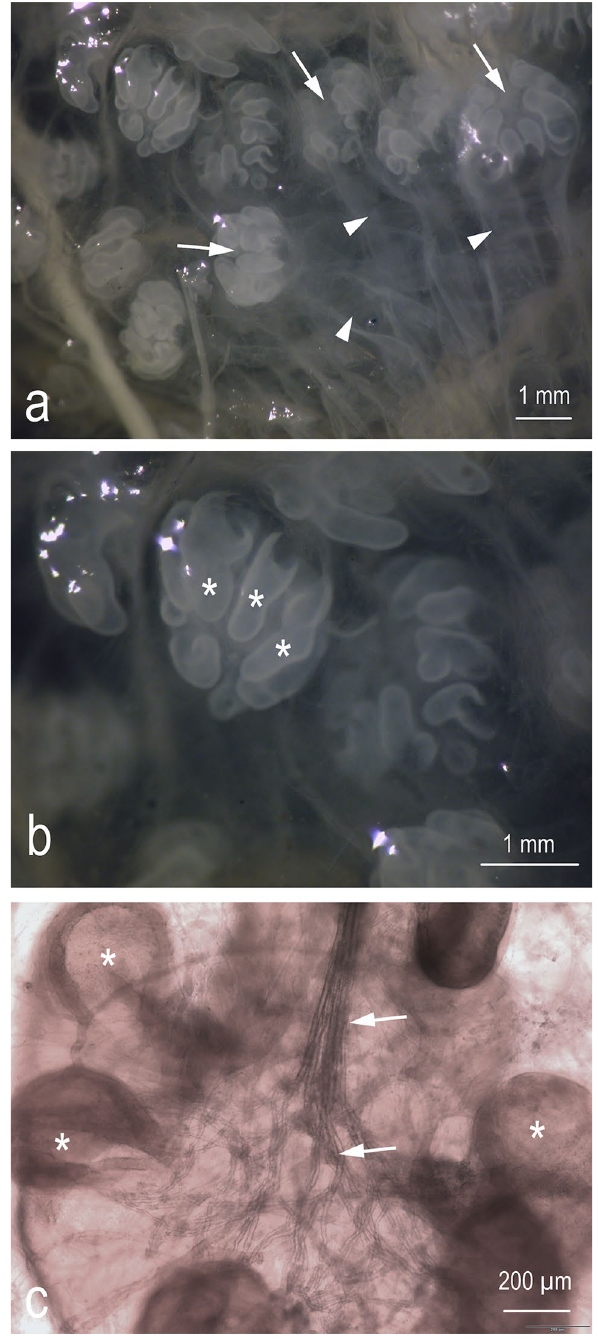
Figure 5. Ampullary electroreceptors of C. monstrosa . ( a ) stereomicroscope photograph of a group of Ampullae. The canals are slightly visible (arrowheads) and ends in the ampullary part (arrows). ( b ) detail of figure ( a ). The ampullary part is subdivided in chambers (asterisks). c) A whole ampulla through the light microscope. The transmitted light allows to observe the nerve fibers (arrows) in the center of the ampulla, among the chambers